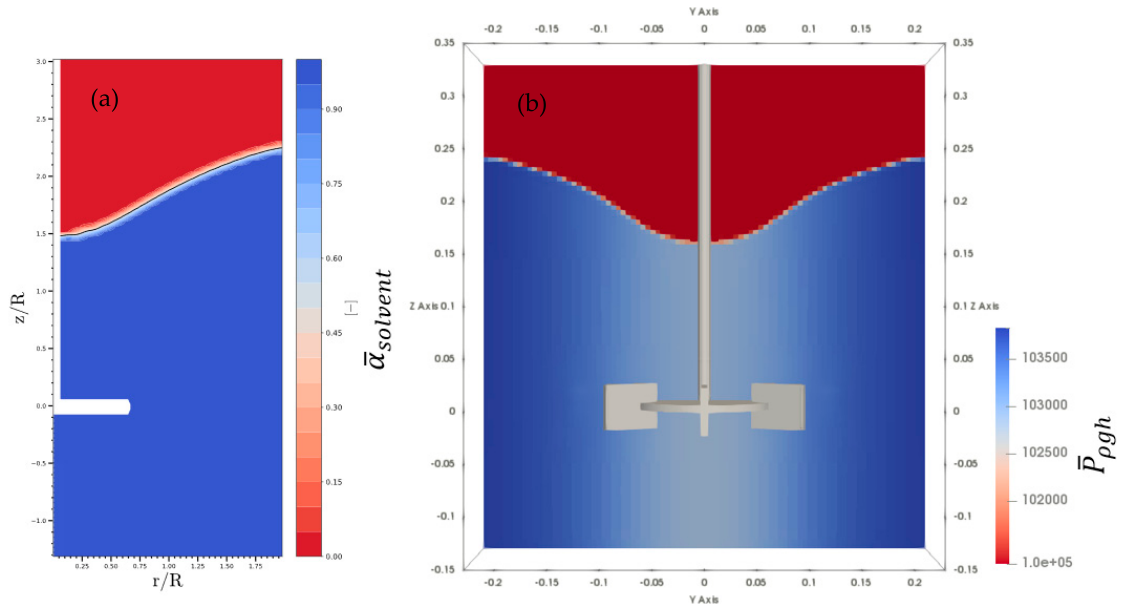
Figure 5. ( a ) Development of surface vortex ( α solvent ) and ( b ) dynamic pressure field ( P rgh ) of a cross-section of the stirring tank.